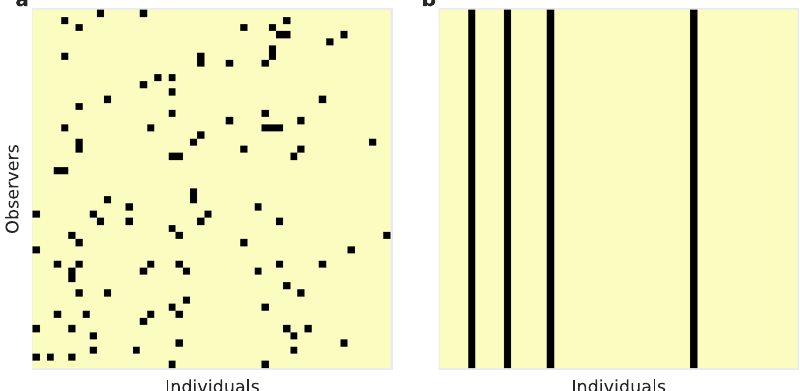
Fig. 1 Reputation matrices showing good (yellow) and bad (black) reputations of individuals (horizontal axis) as seen from the perspectives of different observers (vertical axis). a When moral evaluations are private, observers may disagree on an individual ’ s reputation. Disagreements arise from independent errors in observation or because different observers assess different social interactions involving a focal individual. b Instead of performing moral evaluations independently, people may instead choose to rely on reputations provided by a centralized institution, which in this fi gure consists of Q = 2 distinguished observers ( fi rst two rows) who broadcast their consensus views. When the entire population relies on the public institution for moral assessment, reputational disagreements are eliminated and cooperation can be